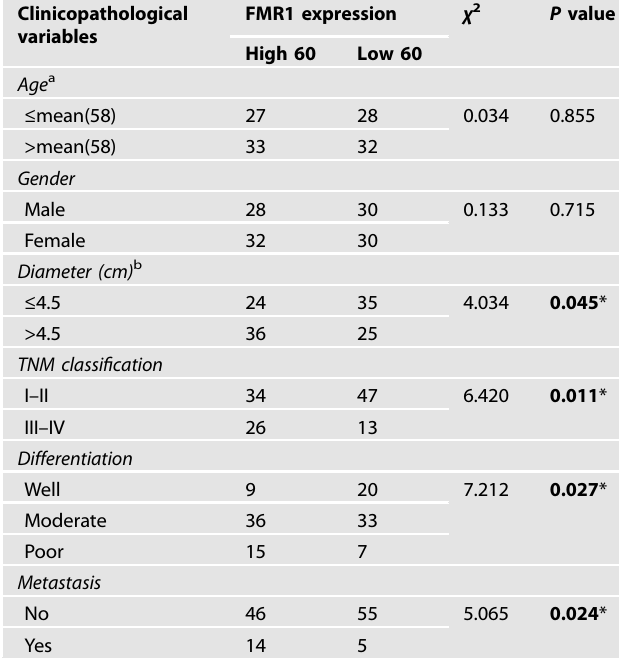
Table 1. The relationship between FMR1 expression and clinicopathological